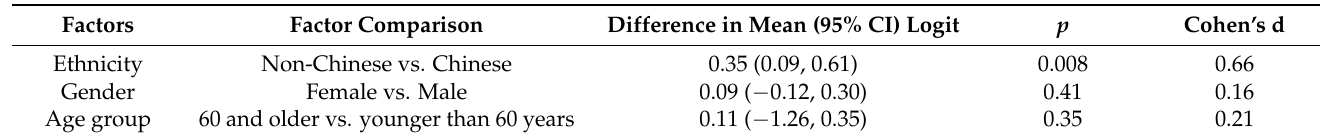
Table 3. Effect size shown as person location (mean (95% CI) logit) and Cohen’s d for ethnicity, gender, and age.